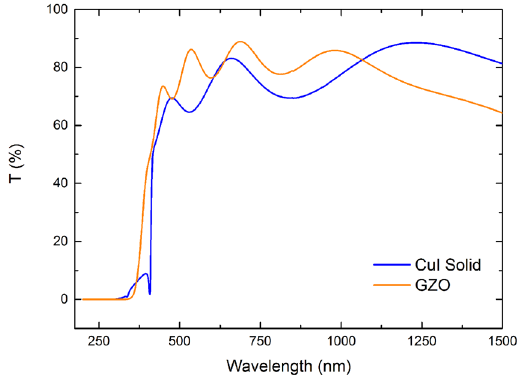
Figure 5. Transmittance spectra of CuI and GZO films produced by the solid iodination and sputtering methods,